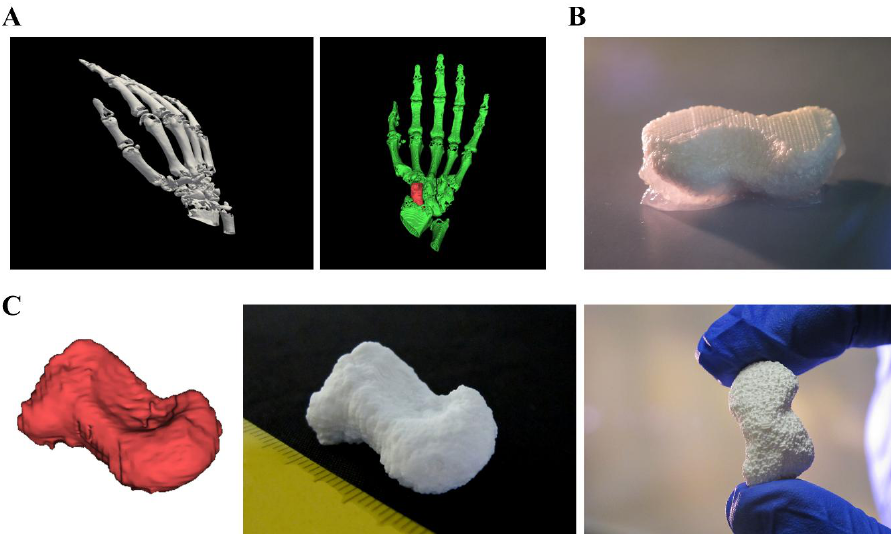
Figure 7. Fabrication of a scaphoid bone from clinical CT data. ( A ) 3D rendered human right hand and selection of the scaphoid by usage of 3D rendering software. ( B ) 3D multichannel plotting of the scaphoid bone consisting of CPC with mc10 as support ink. ( C ) Comparison of the stl-file and the real plotted structure with the characteristic shape of the human scaphoid.